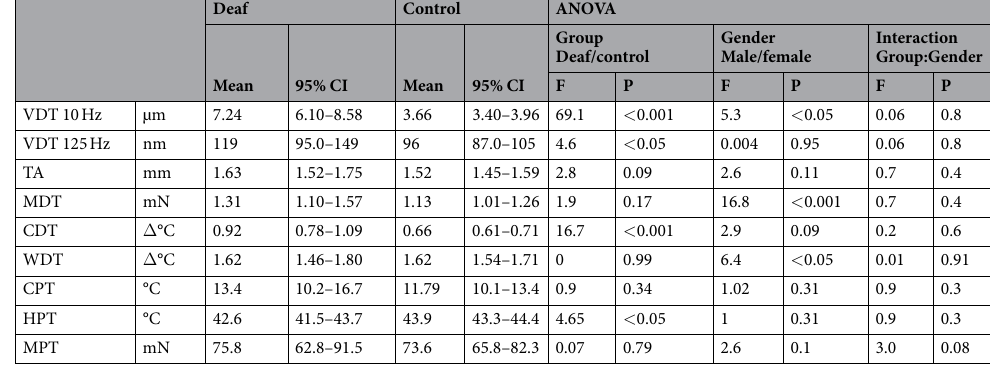
Table 1. Analysis of variance, mean values and confidence intervals for psychophysical tests. Mean values of VDT 10 Hz & 125 Hz, TAC, MDT, CDT, WDT, CPT, HPT, MPT were calculated by back transformation from the log-means. CI, confidence interval. VDT 10 Hz and 125 Hz, vibration detection threshold at 10 Hz and 125 Hz; TA, tactile acuity; MDT, mechanical detection threshold; CDT cold detection threshold; WDT, warmth